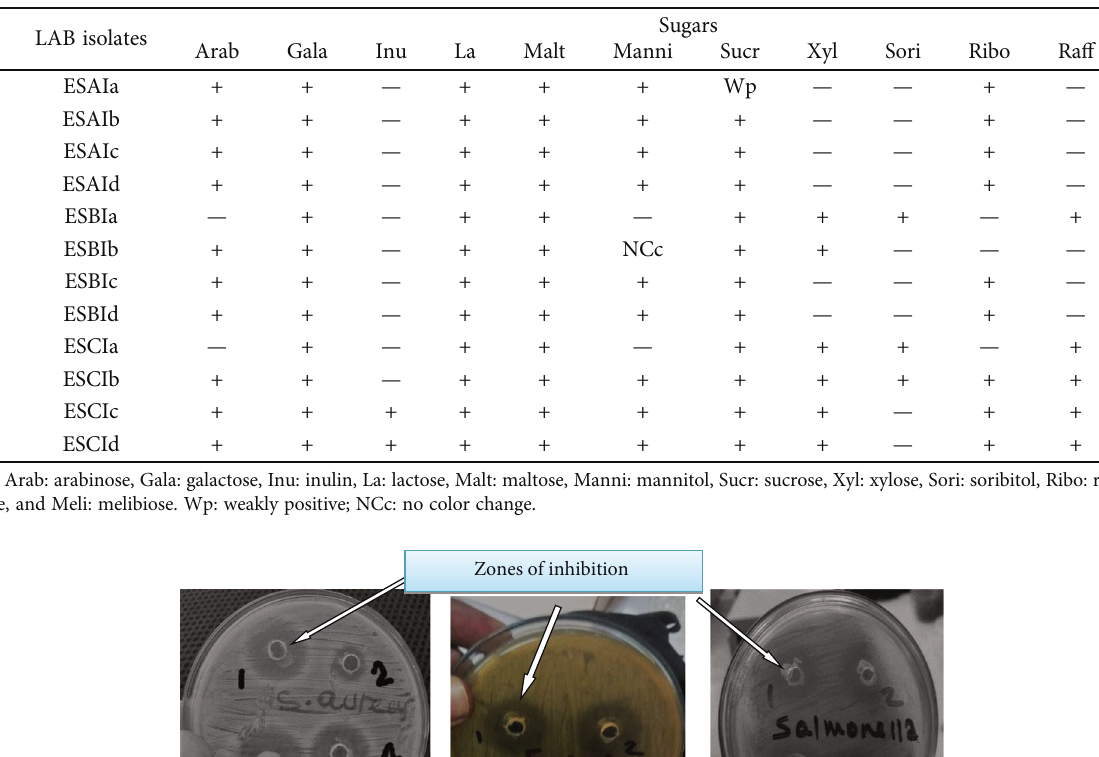
Table 3: Identi fi cation of LAB isolates by using API 50 CHL test strips.